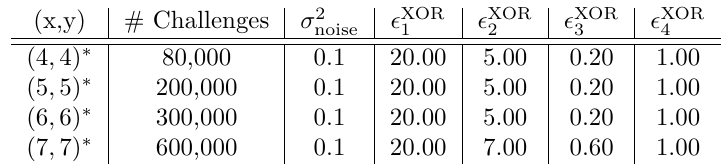
(cid:15) XOR (cid:15) XOR (cid:15) XOR (cid:15) XOR noise 1 2 3 4